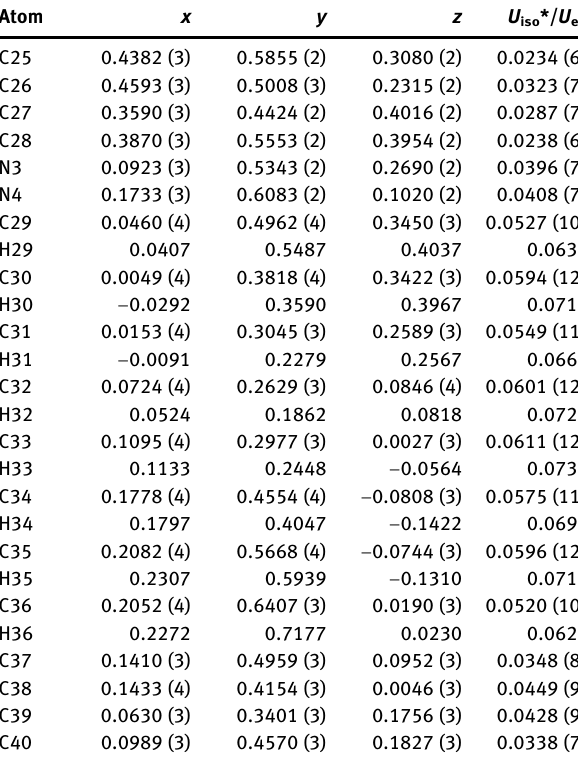
Table 2 contains the list of the atoms including atomic coordinates and displacement parameters.